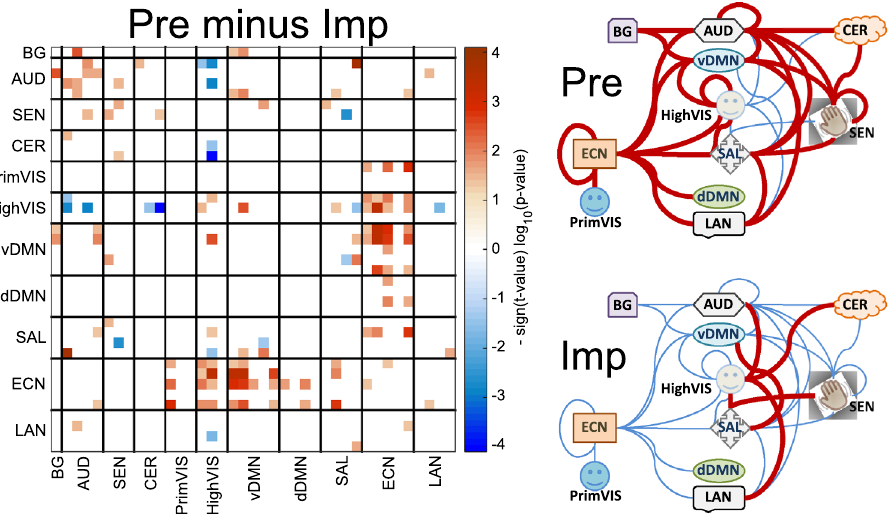
Figure 7. Significant results for the “prelearned minus improvised” contrast. In general, the prelearned condition exhibits significantly higher connectivity values. Non-significant results are displayed in white. On the right side panel, red thick lines indicate stronger connectivity and blue thinner lines indicate